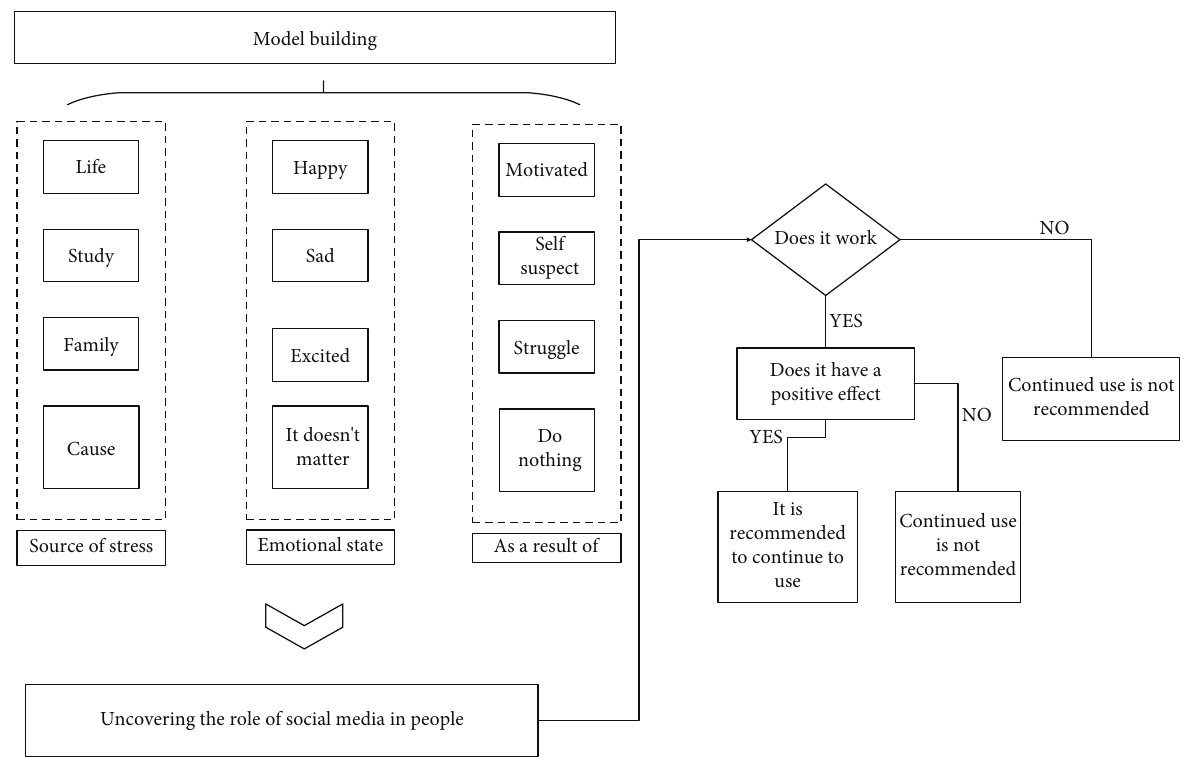
Figure 3: Stressor-Strain-Outcome theoretical model.